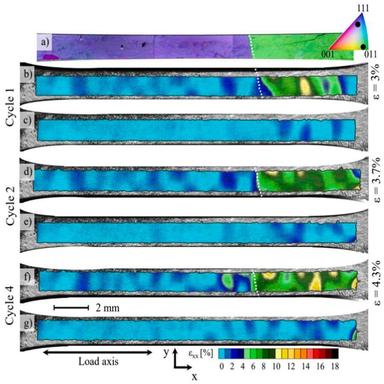
(a) Crystallographic orientation of the oligocrystalline tensile specimen in the colors of the inverse pole figure according to the load axis (horizontal). Local strain fields plotted with respect to the load axis (horizontal) εxx at the state of maximum strain with marked HAGB (white dotted line) (b), (d), (f), and after unloading (c), (e), (g). (For interpretation of the references to color in this figure legend, the reader is referred to the Web version of this article.)